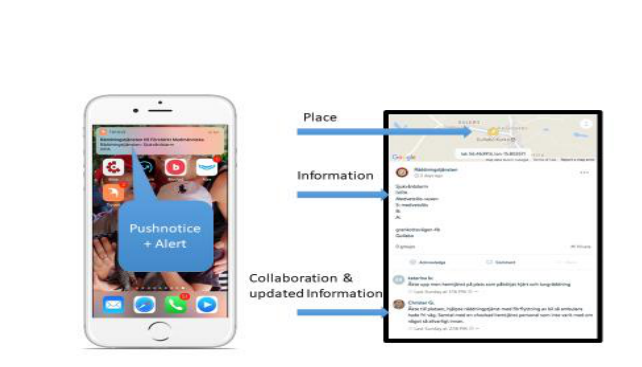
Figure 1. Dispatching of volunteers through the app. The type of incident here is a single-vehicle traffic accident in which the victim is